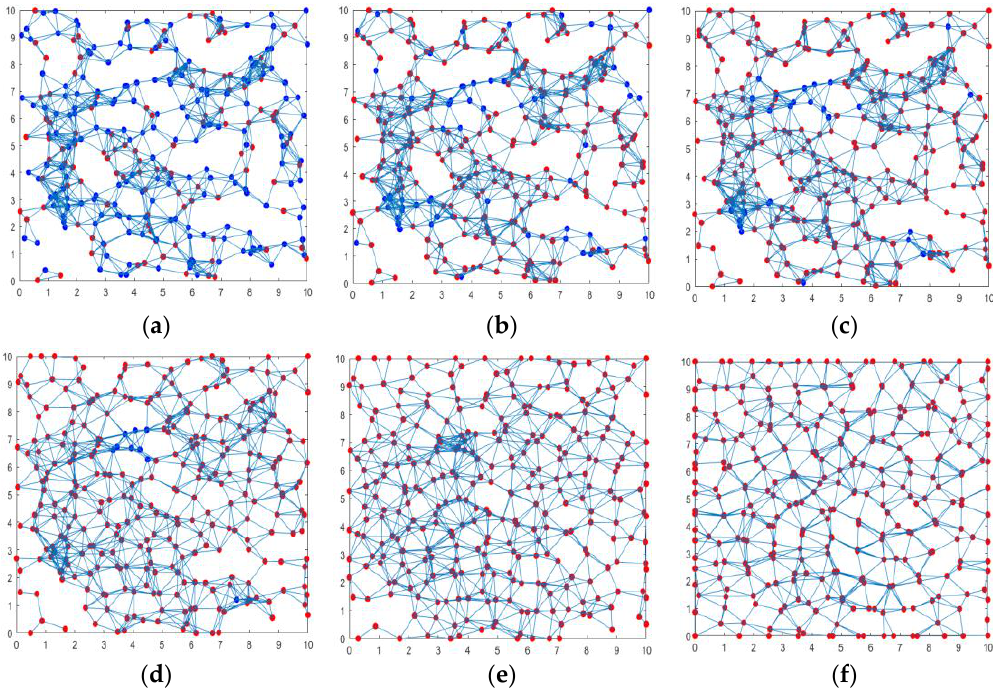
Figure 6. Defector model evolution process. ( a ) t = 0; ( b ) t = 20; ( c ) t = 60; ( d ) t = 100; ( e ) t = 150; ( f ) t = 200.